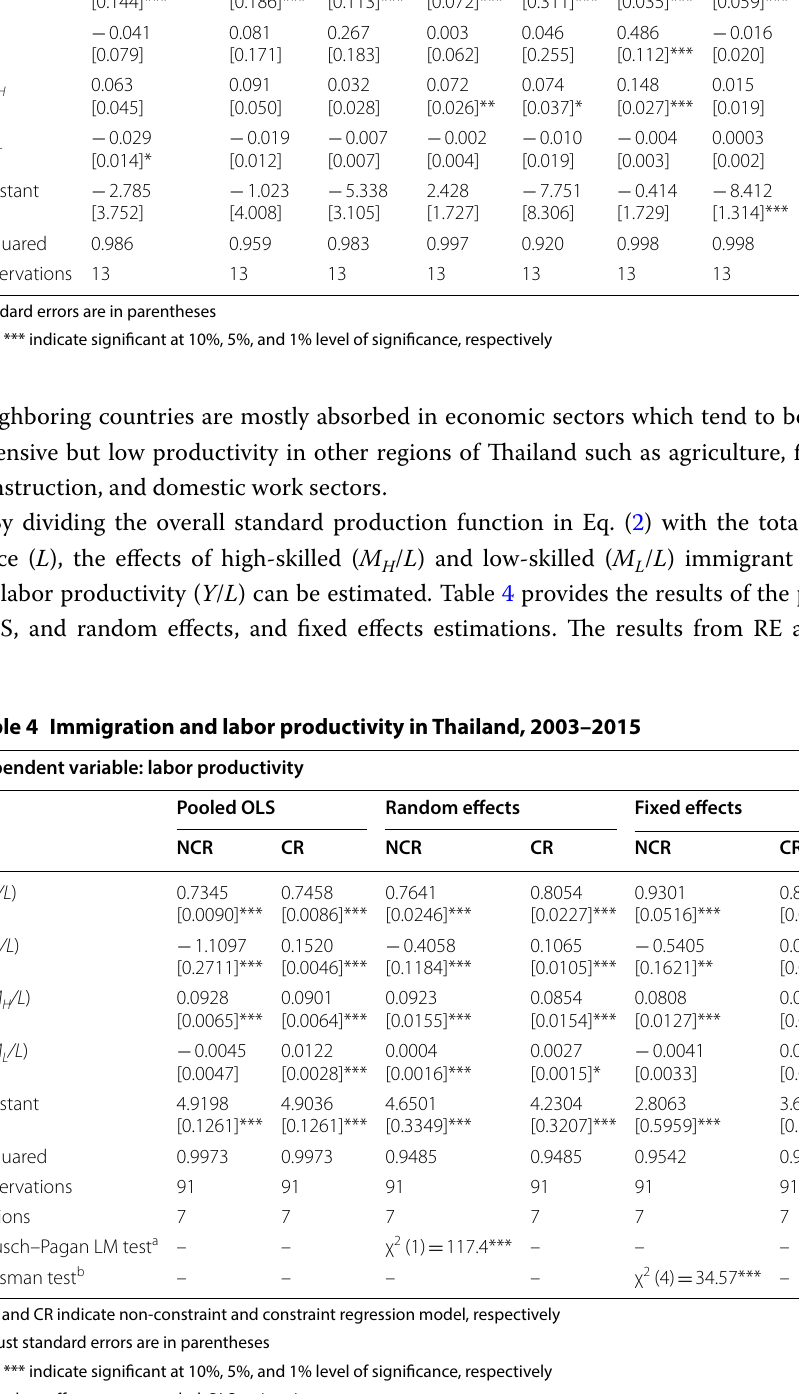
NCR and CR indicate non-constraint and constraint regression model, respectively Robust standard errors are in parentheses *, **, *** indicate significant at 10%, 5%, and 1% level of significance, respectively